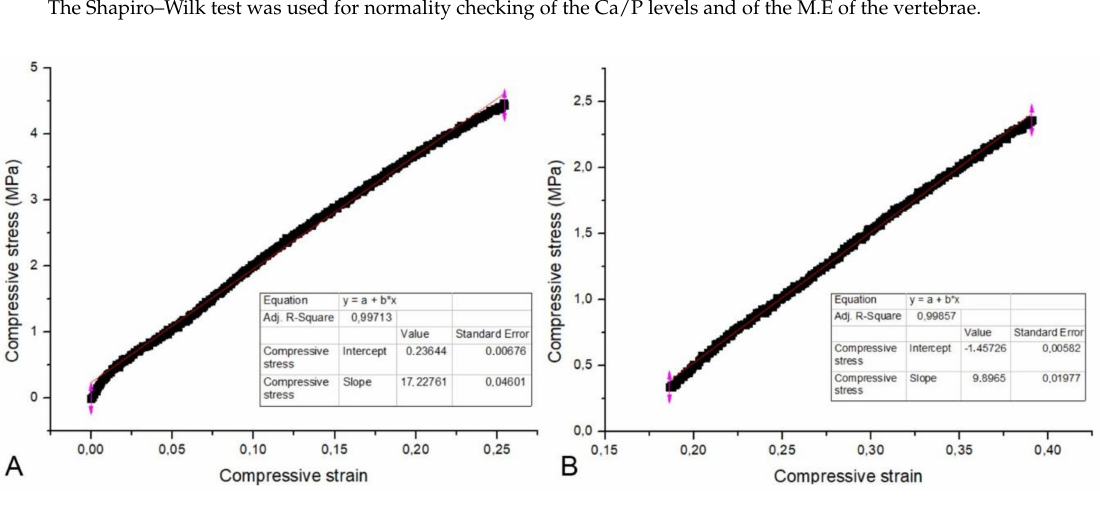
Figure 6. Estimation of modulus of elasticity from ( A ) seabreams without any skeletal deformity and ( B ) seabreams with